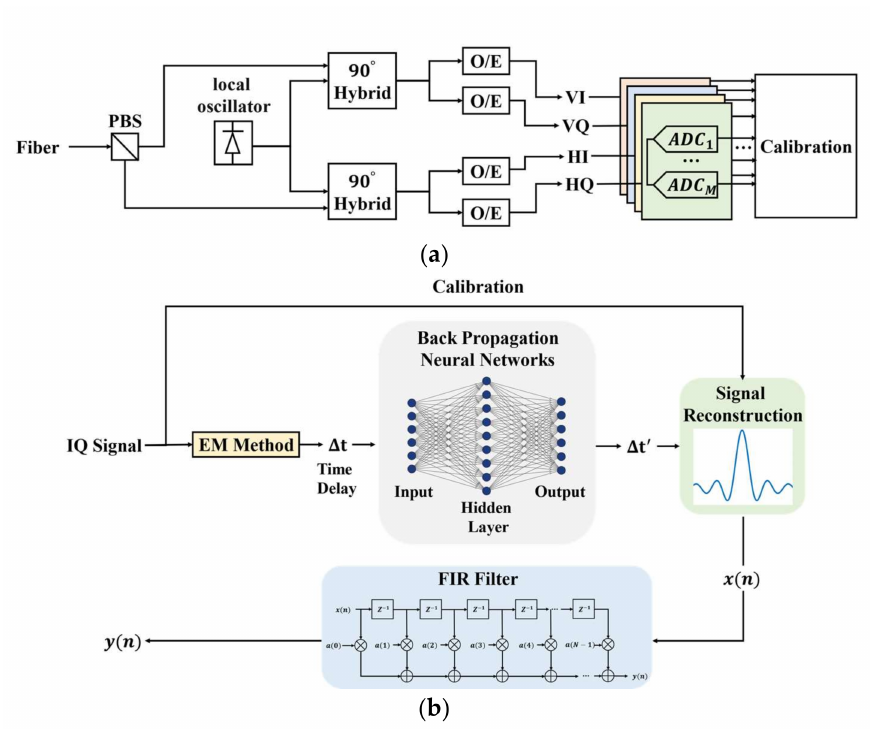
Figure 1. ( a ) The diagram of the optical coherent communication system and the role the ADC played in the system; ( b ) the flowchart of the calibration